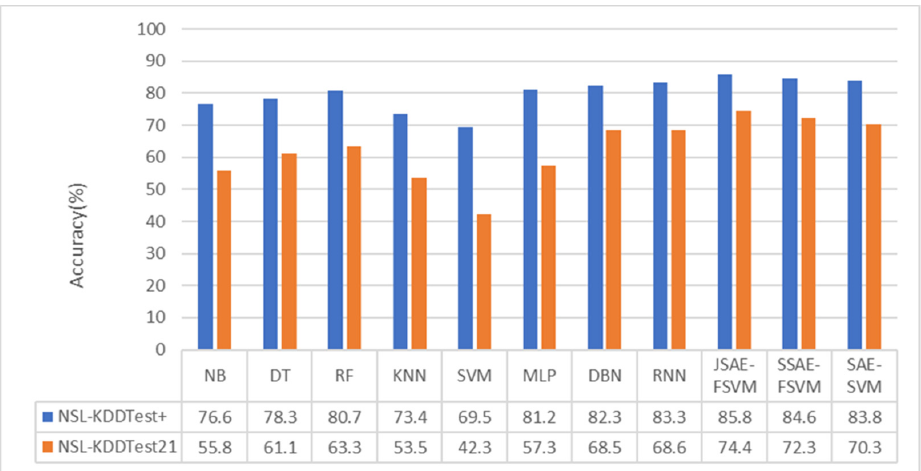
Figure 6. Binary-category classification accuracy.